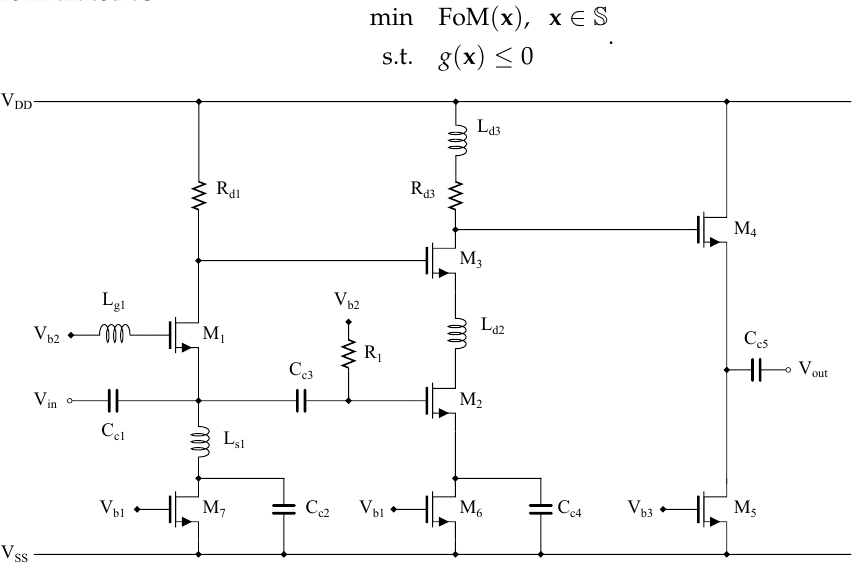
Figure 8. The wideband, noise canceling LNA [28] considered in this